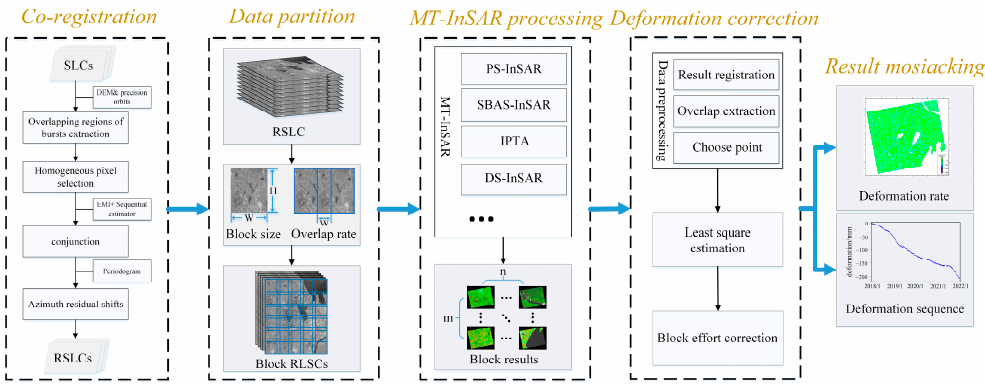
Figure 1. Flowchart of the block MT-InSAR algorithm.